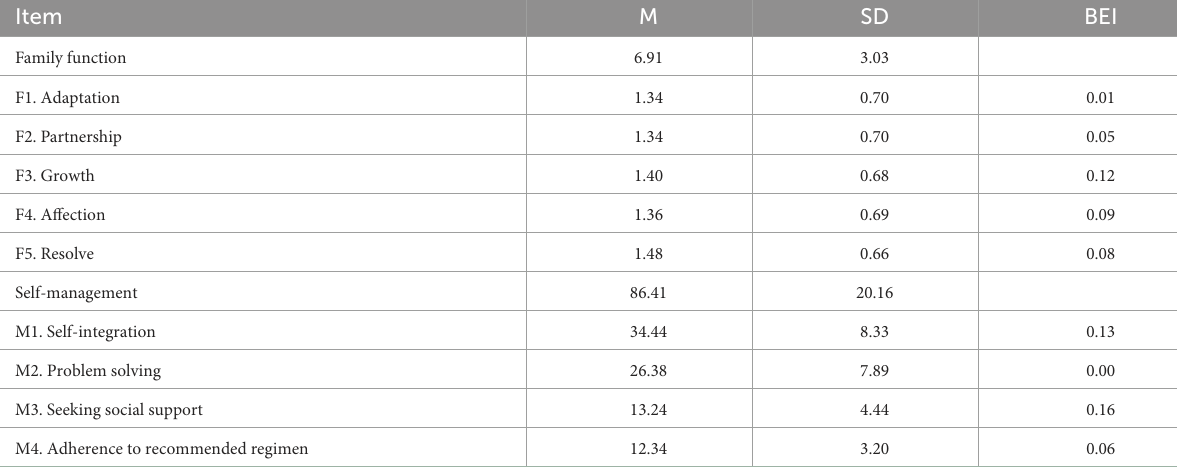
TABLE 2 Mean scores, standard deviations and BEIs for each item in the network ( N =